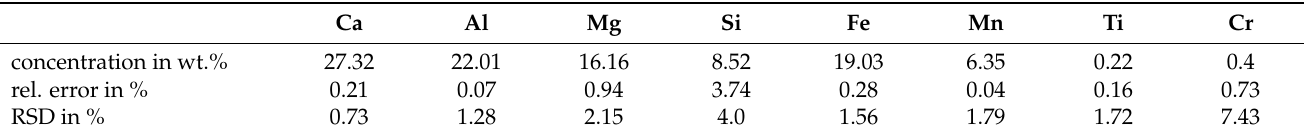
Table 3. Accuracy and precision of MC analysis; % concentrations of elements are recalculated from concentrations of oxides given in Table